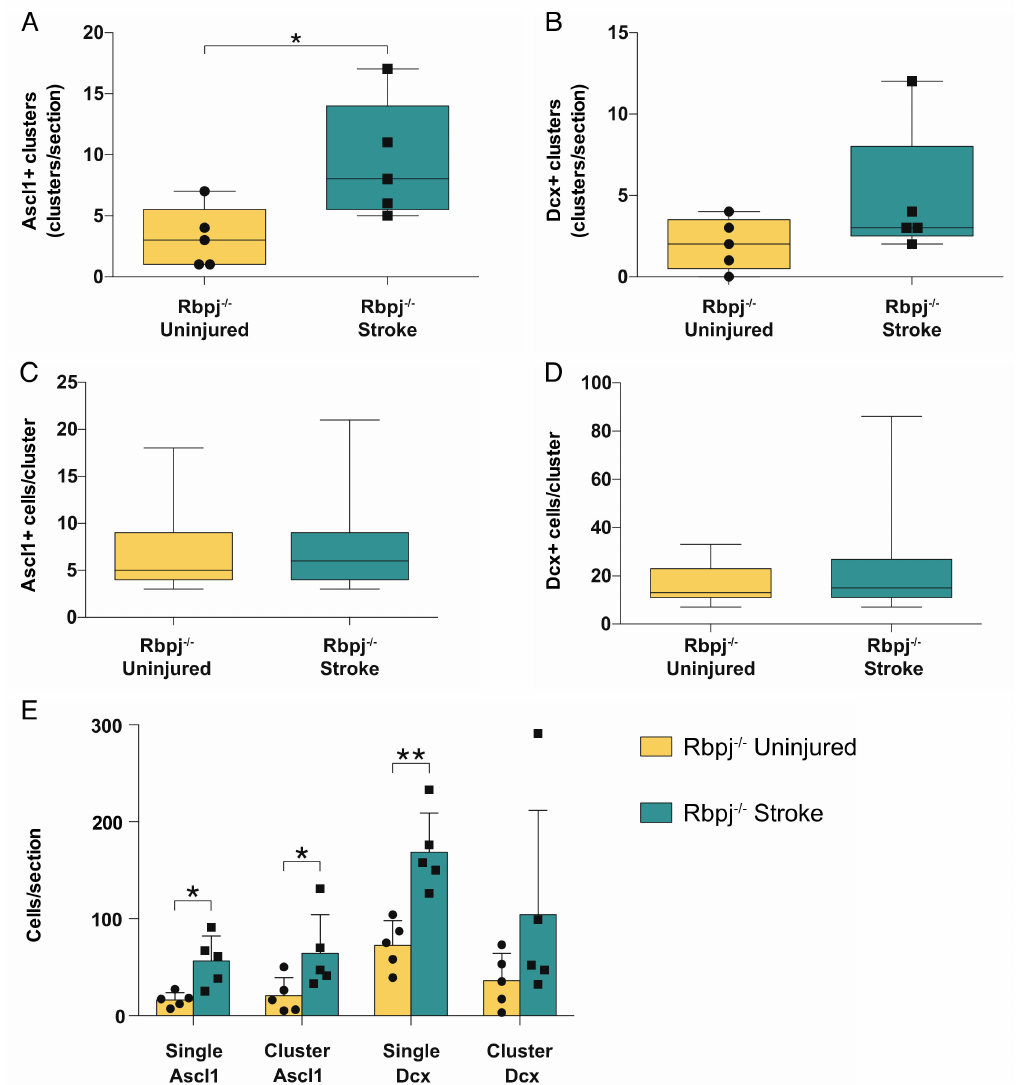
Figure 3. Analysis of cluster number and size. Analysis of the Ascl + and Dcx + clusters in the stroke side compared to the uninjured striatum: ( A , B ) Quantification of the total number of clusters. Groups of Ascl1 + cells have been defined as clusters only when found in contact with each other and in numbers ≥ 3 cells; Dcx + cells had to be in groups ≥ 7 to be considered a cluster. The number of Ascl1 + clusters was significantly higher in the stroke side compared to the uninjured striatum ( p = 0.014); ( C , D ) Analysis of the size of Ascl1 + and Dcx + cells in the stroke and uninjured striatum; ( E ) Analysis of the total number of cells found in clusters and as singlets. Ascl1 + / Tomato + cell numbers are increased both as single cells ( p = 0.022) and in clusters ( p = 0.023), while there is a significant increase only in the number of Dcx + / Tomato + neuroblasts singlets ( p = 0.0097). The data were analyzed using a paired t-test and are presented as mean ±